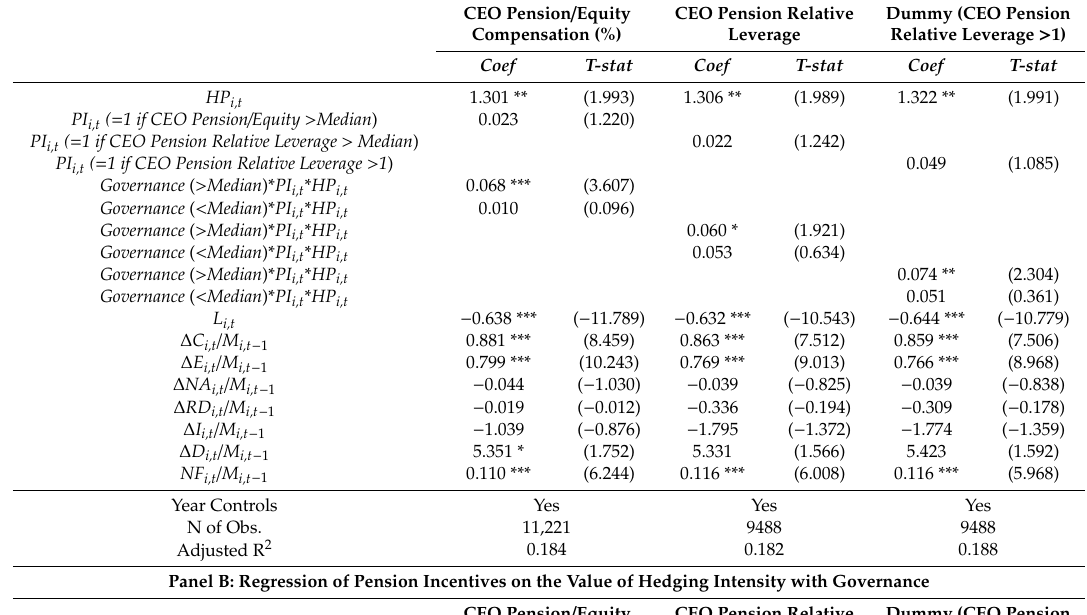
Panel B: Regression of Pension Incentives on the Value of Hedging Intensity with Governance CEO Pension / Equity Compensation